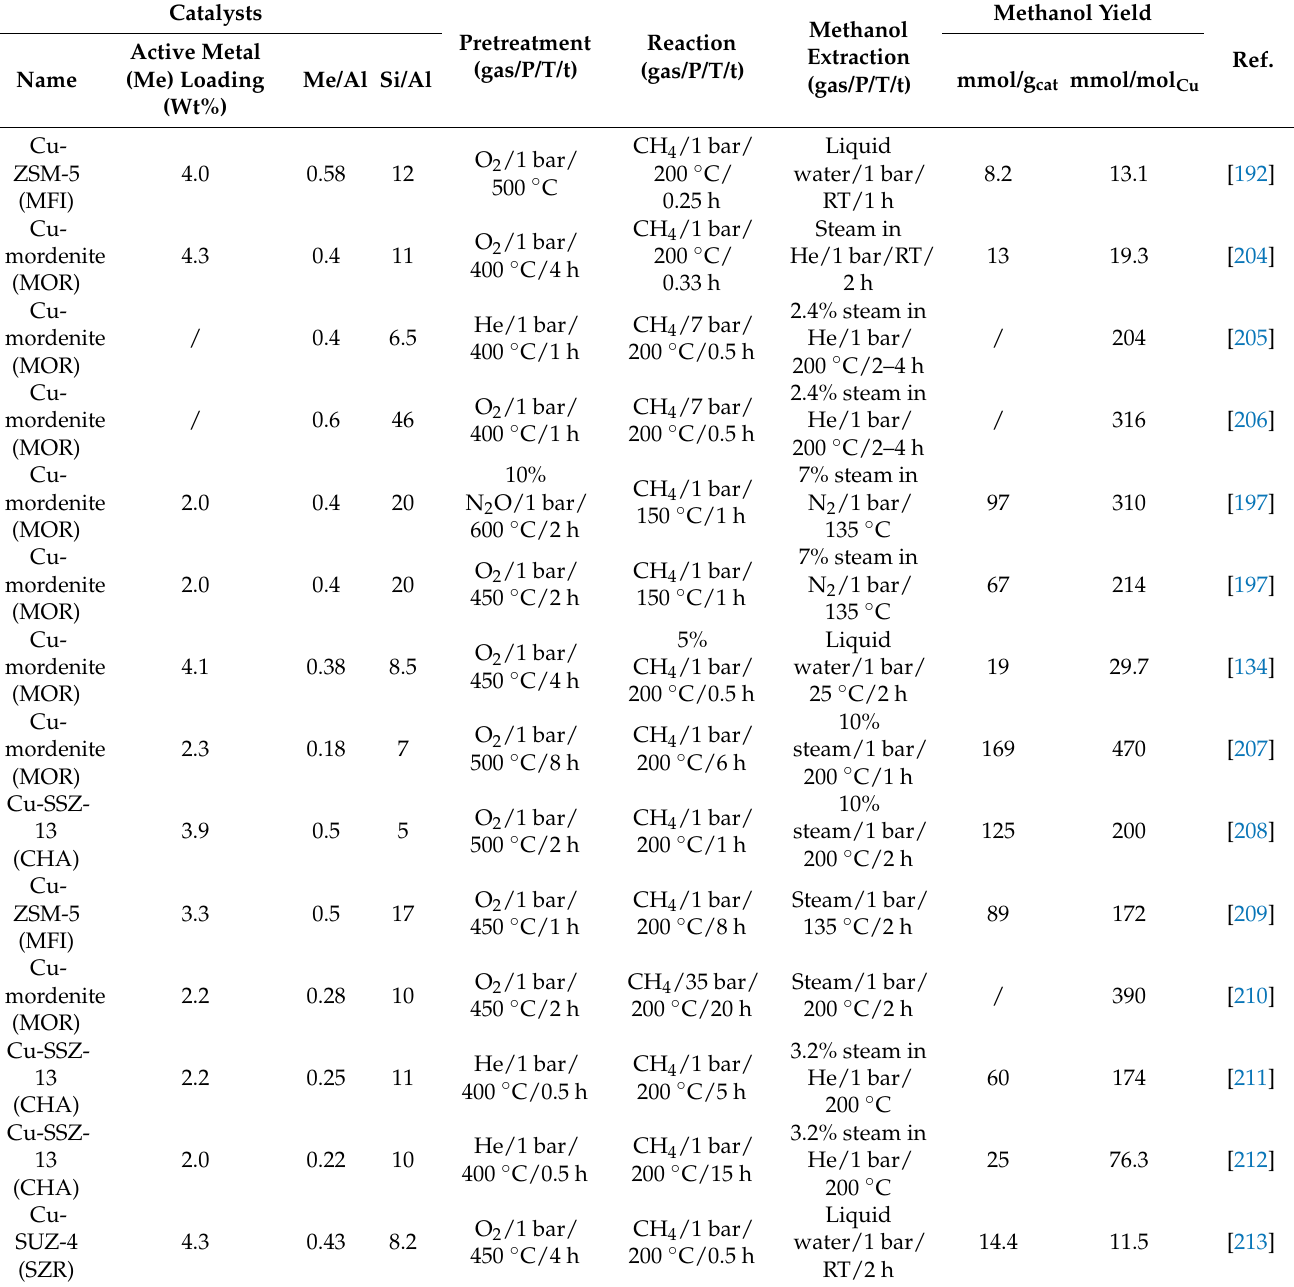
Table 3. Summary of catalysts and their catalytic activity for gas-phase multi-step conversion of methane into